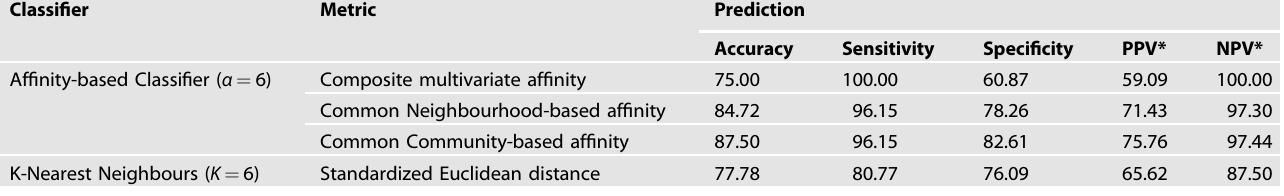
Table 6. Performance evaluation of af fi nity-based and weighted KNN classi fi cation in the prediction dataset.